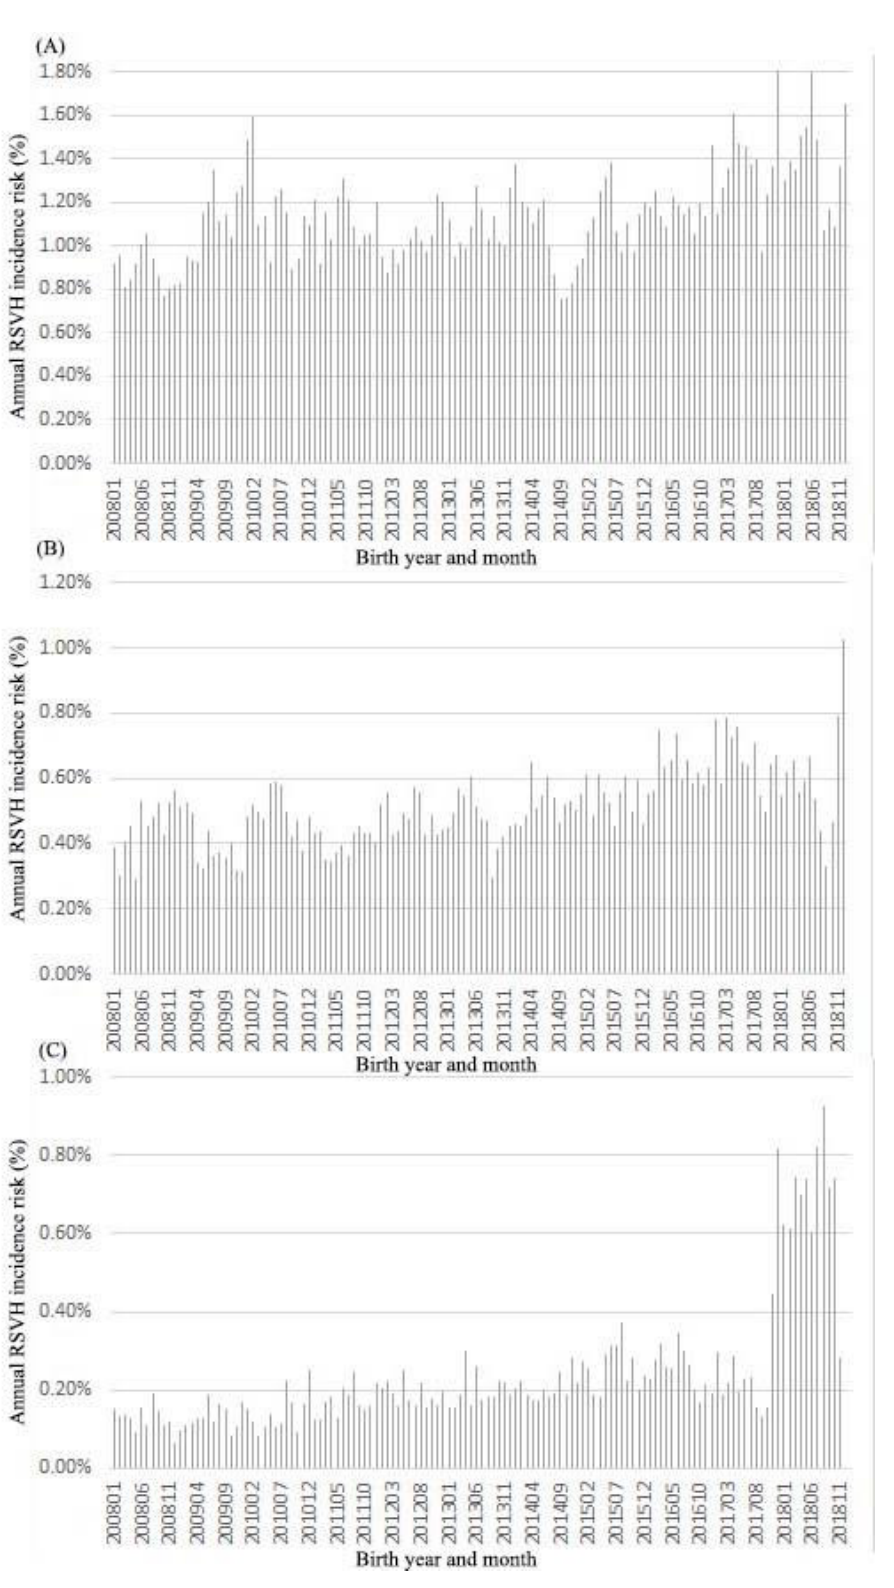
Figure 5. RSVH risk among different birth months for one- ( A ), two- ( B ), and three- ( C ) year-olds. According to the birth month and year, we checked the RSVH rate of children born between January 2008 (200801) and December 2018 (201812) every year until 3 years old.